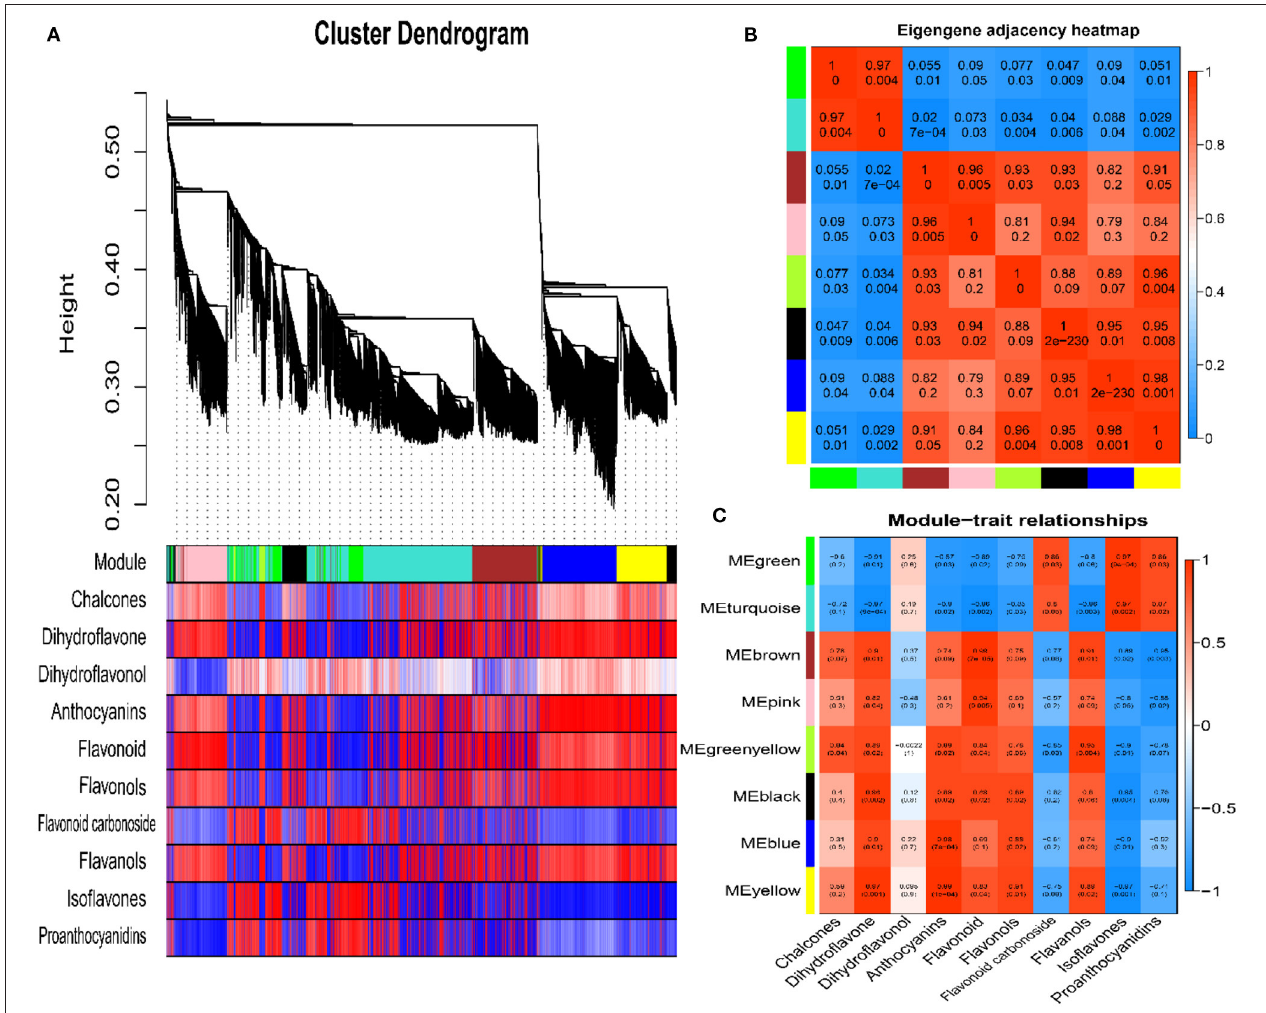
FIGURE 4 | Weighted gene co-expression network analysis. (A) Cluster dendrogram of differentially expressed genes. (B) Eigengene adjacency heat map. (C) Module-trait relationships (upper values are the correlation coefficients, and lower values are the p